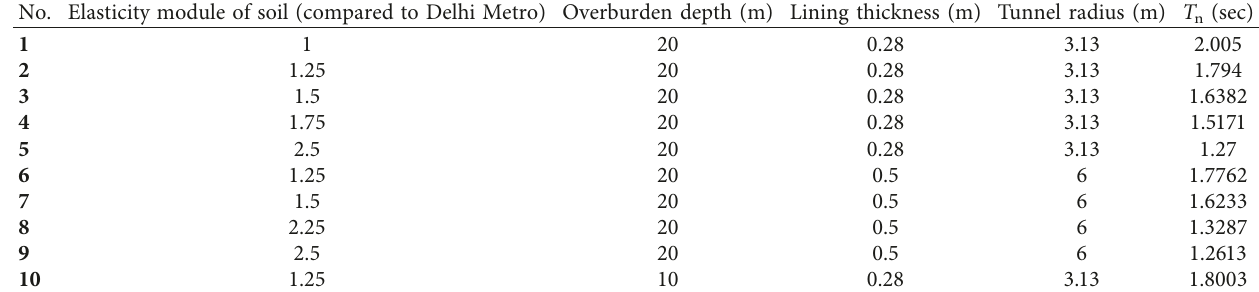
Table 9: Properties of models that presence of the tunnel amplifies the acceleration spectrum at a distance of 15.17 m from the center of the tunnel projection onto the ground